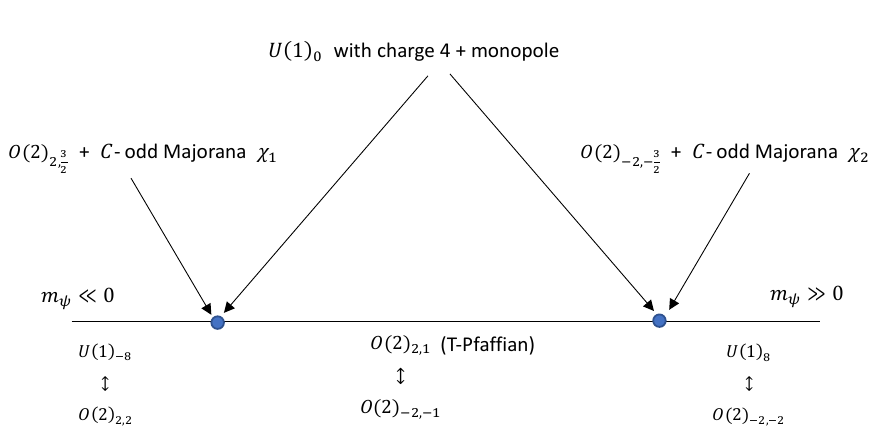
Figure 2: The phase diagram of U ( 1 ) gauge theory coupled to a Dirac fermion of charge four, with a minimally charged magnetic monopole perturbation. In the two dual descriptions the Majorana fermion χ couples to the (cid:90) the transformation χ → − χ . The low energy TQFT is the T-Pfaffian